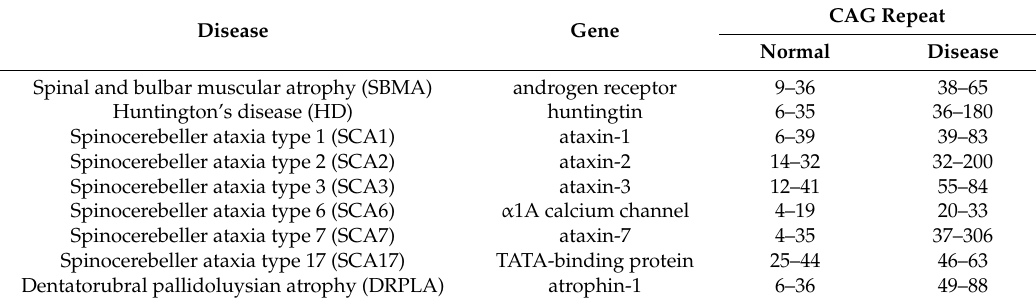
Table 1. The polyglutamine diseases; CAG: